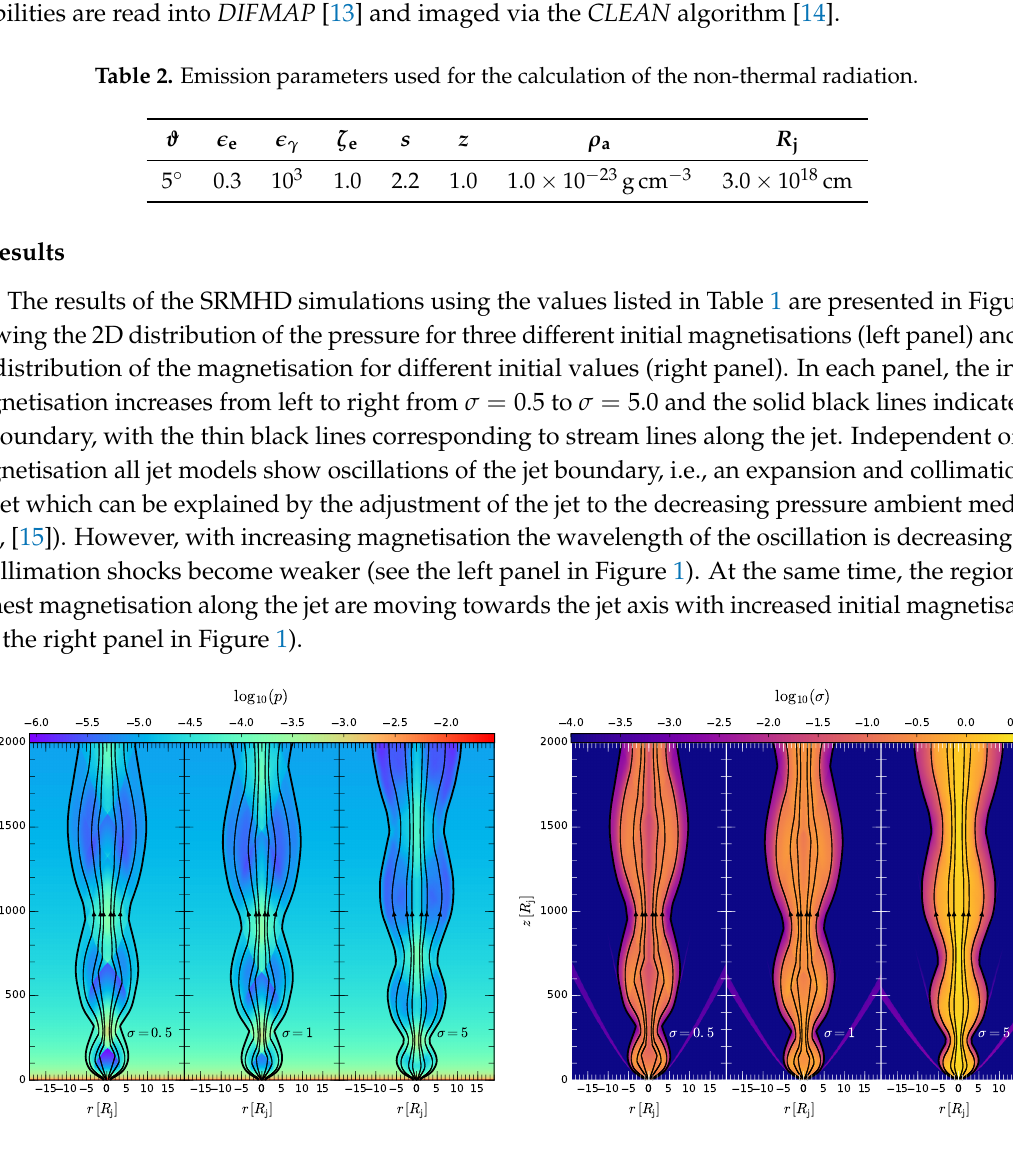
Figure 1. 2D distribution of the pressure ( left panel ) and magnetisation ( right panel ) for different initial magnetisations (for details see